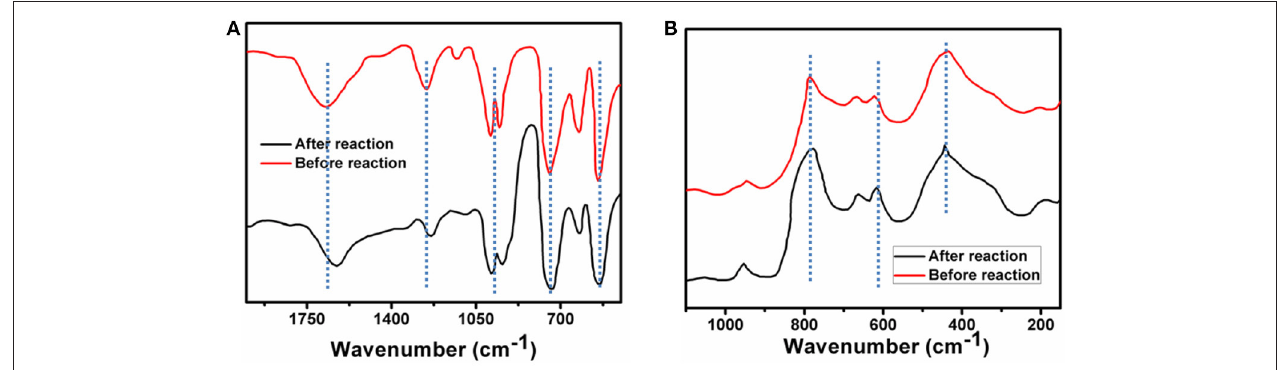
FIGURE 5 | (A) FT-IR spectrum of {Mo 368 }, black line corresponds to FT-IR spectrum of before reaction and brown line corresponds to FT-IR spectrum of after reaction. (B) Raman spectrum of {Mo 368 }, black line corresponds to Raman spectrum of before reaction and brown line corresponds to Raman spectrum of after